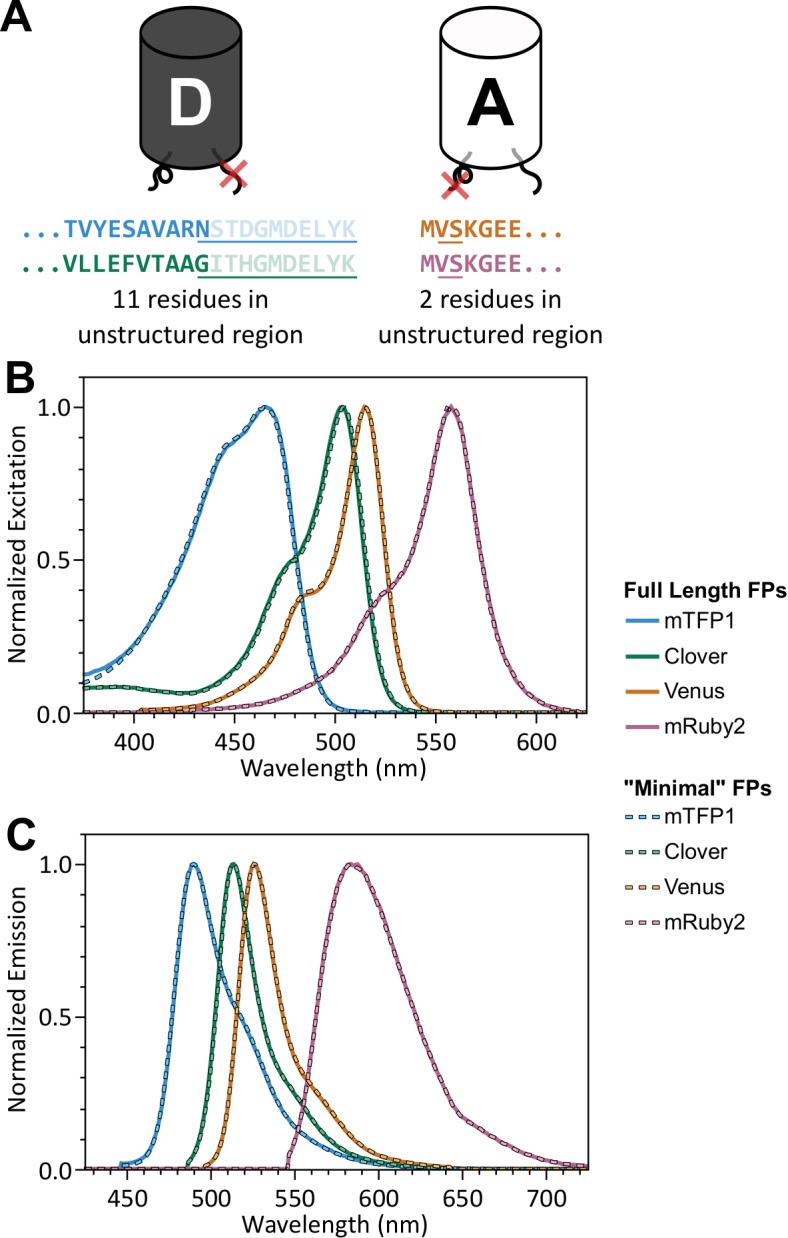
‘Minimal’ FPs exhibit spectral properties indistinguishable from full-length parent FPs.(A) Schematic of donor and acceptor FPs highlighting 11 C-terminal residues (donor FP) and 2 N-terminal residues (acceptor FP), which do not contribute to beta barrel structure, but are highly conserved between various FPs; residues not appearing in crystal structures are faded (PDB 2HQK and 1MYW for donor and acceptor FPs, respectively); residues that were removed are underlined. (B, C) Normalized excitation (B) and emission (C) spectra for full length and ‘minimal’ versions of mTFP1, Venus, Clover, and mRuby2.10.7554/eLife.33927.009Figure 1—figure supplement 3—source data 1.Fluorescent protein spectra.